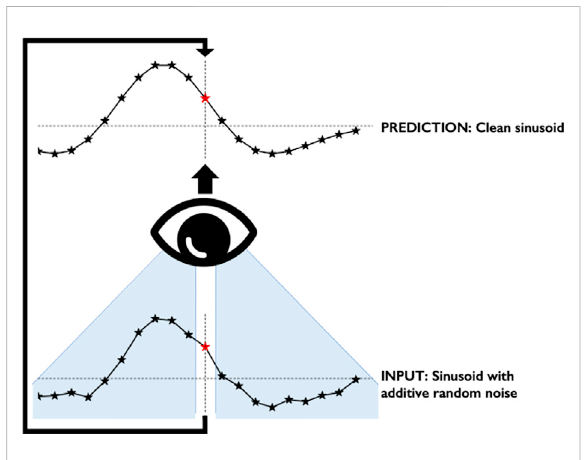
FIGURE 1 Schematic illustration of a noisy trace undergoing blind-spot denoising. For the prediction of a central value (red star), the input to the network is the nearby samples (blue area). The central value is not used in the prediction of its own